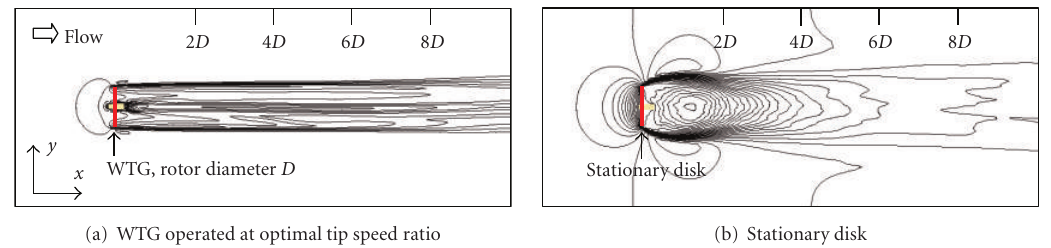
Figure 10: Contour plots of the streamwise ( x ) velocity component, u , with 30 equally spaced contour intervals between u/U = − 0 . 7 and u/U = 1 . 4, time-averaged field, top view of the entire domain at z =